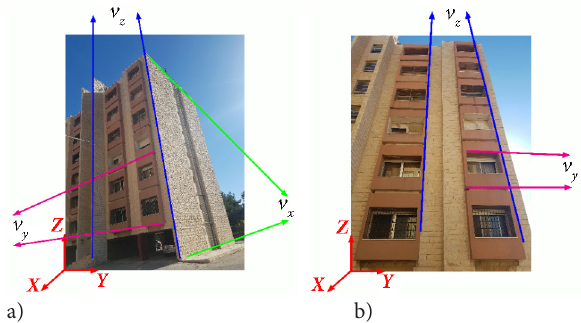
Figure 6. Vanishing points detection: a – three orthogonal vanishing points; b – two orthogonal vanishing